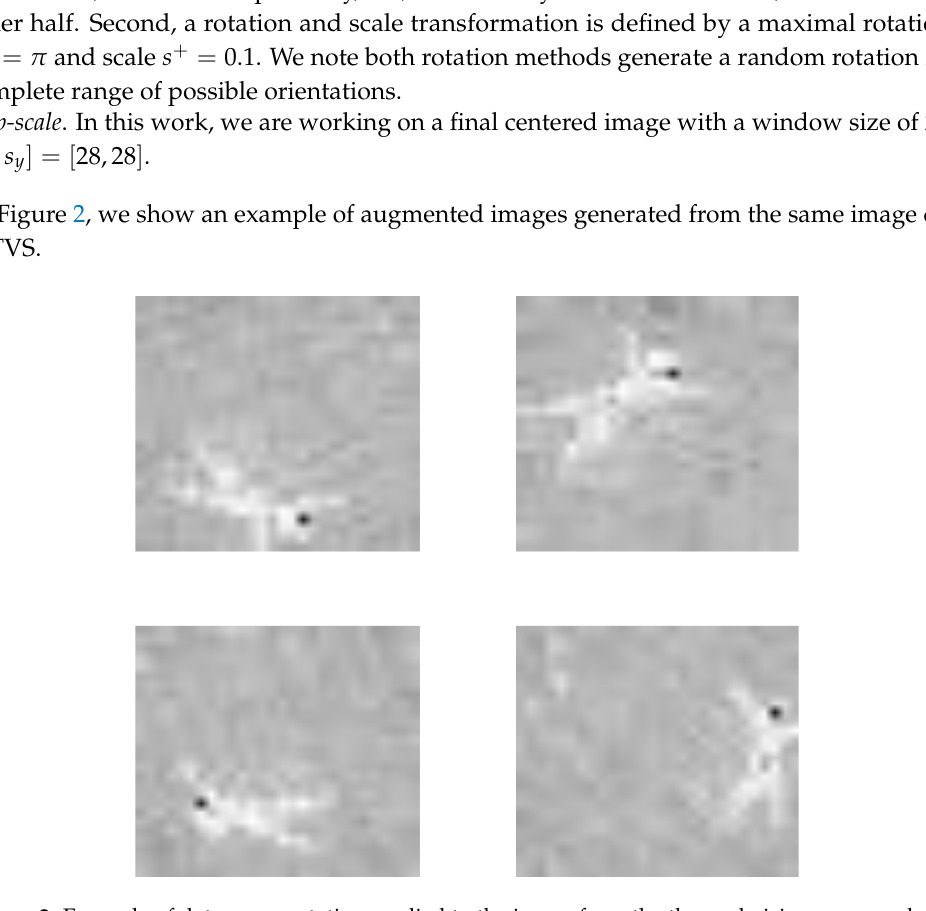
Figure 2. Example of data augmentation applied to the image from the thermal vision sensor, where a fall is